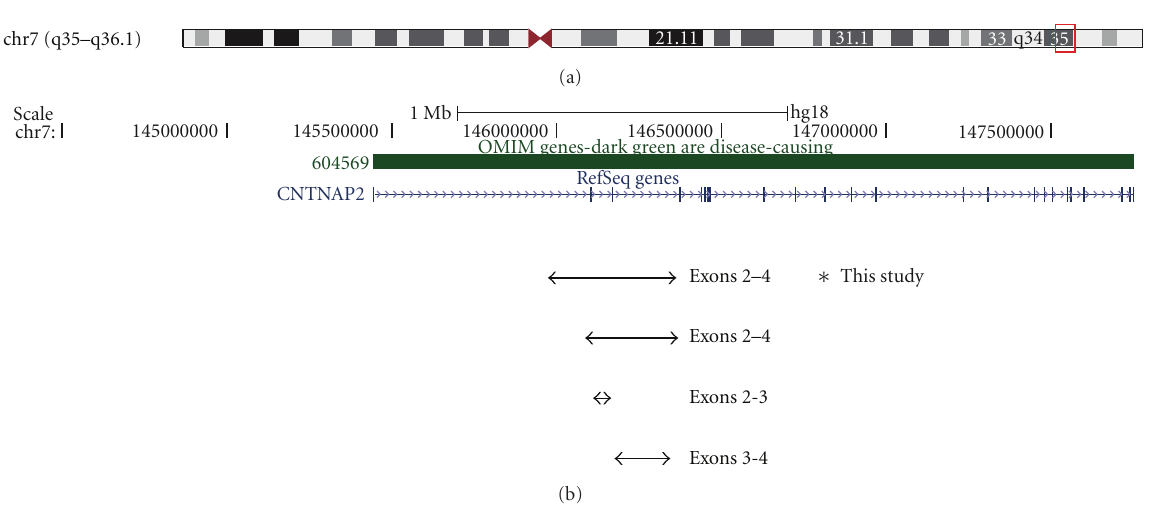
coordinates 3p12.3Chrom. band